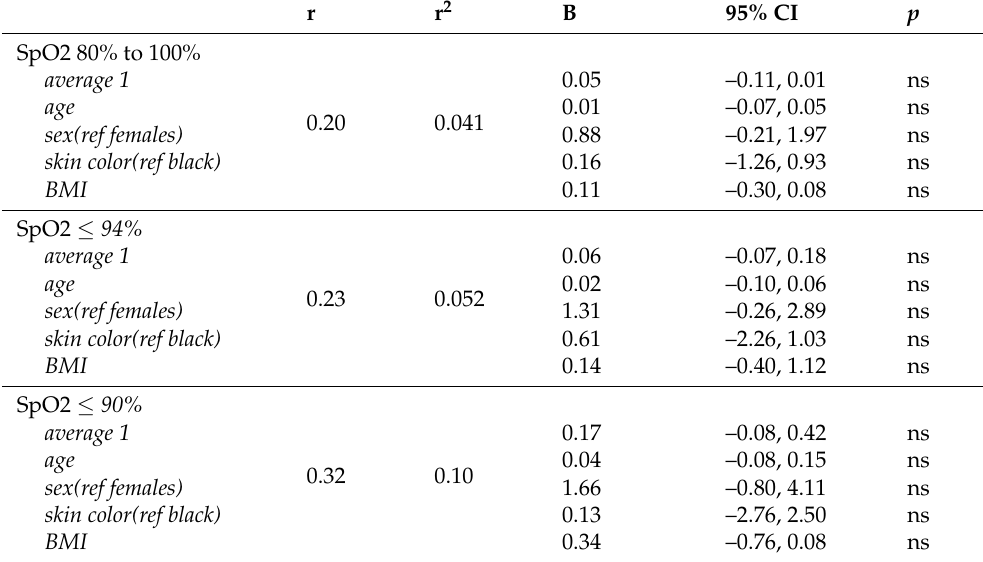
Table 5. Multiple Linear regression analysis with difference (BrOxy M SpO 2 minus Nellcor SpO 2 ) as dependent